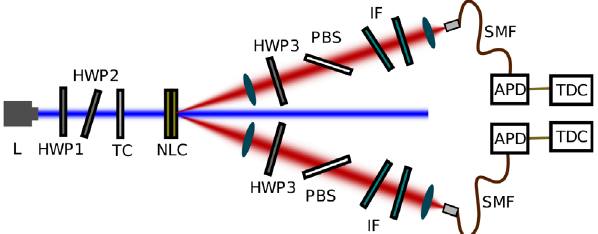
FIG. 2. A diagram of the entanglement source. The high-power laser (L) is prepared in a specific polarization state (depending on the Bell test) by two half-wave plates (HWP1 and HWP2). We precompensate for the temporal decoherence (arising from the group velocity dispersion in the down-conversion crystals) by passing the laser through a crystal (TC) designed to have the opposite group velocity dispersion. Passing the pump through a pair of orthogonal nonlinear crystals (NLC) produces the en- tangled photons. The measurements are performed using a motorized half-wave plate (HWP3) and a polarizing beam splitter (PBS). We then spectrally filter (IF) the photons to limit the collected bandwidth to 20 nm, as well as spatially filter the photons using a single-mode fiber (SMF) to remove any spatial decoherence. Finally, the photons are detected using avalanche photodiodes (APD), the events of which are recorded on a time- to-digital converter (TDC) and saved on a computer for